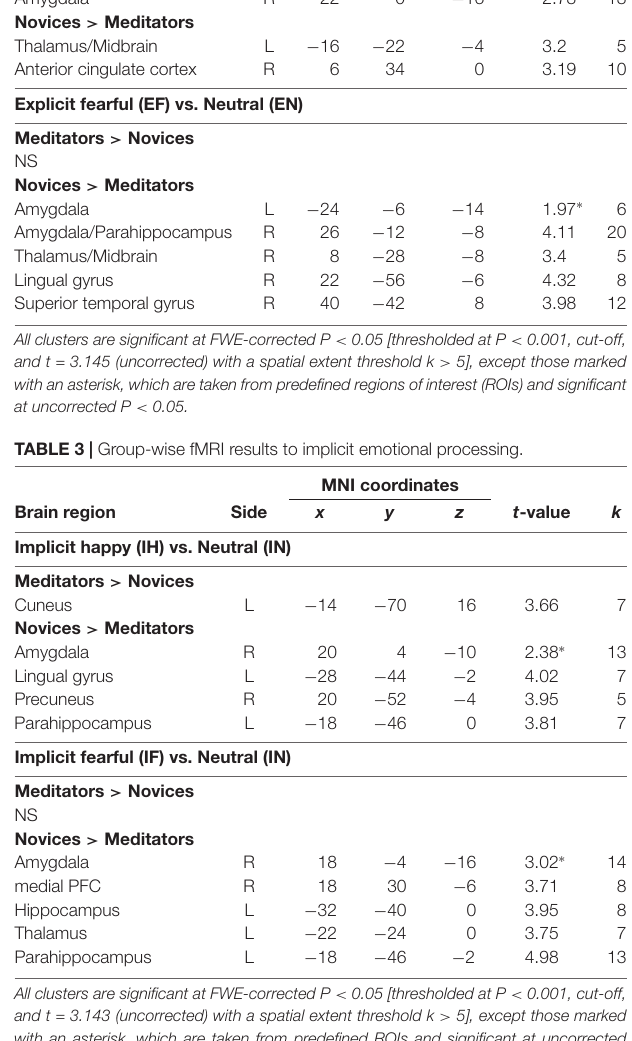
interaction of group × emotion only under the explicit condition TABLE 2 | Group-wise fMRI results to explicit emotional processing. MNI coordinates Brain regions t -value k analyses indicated that the emotion effect in the amygdala had opposite directions depending on the factor of